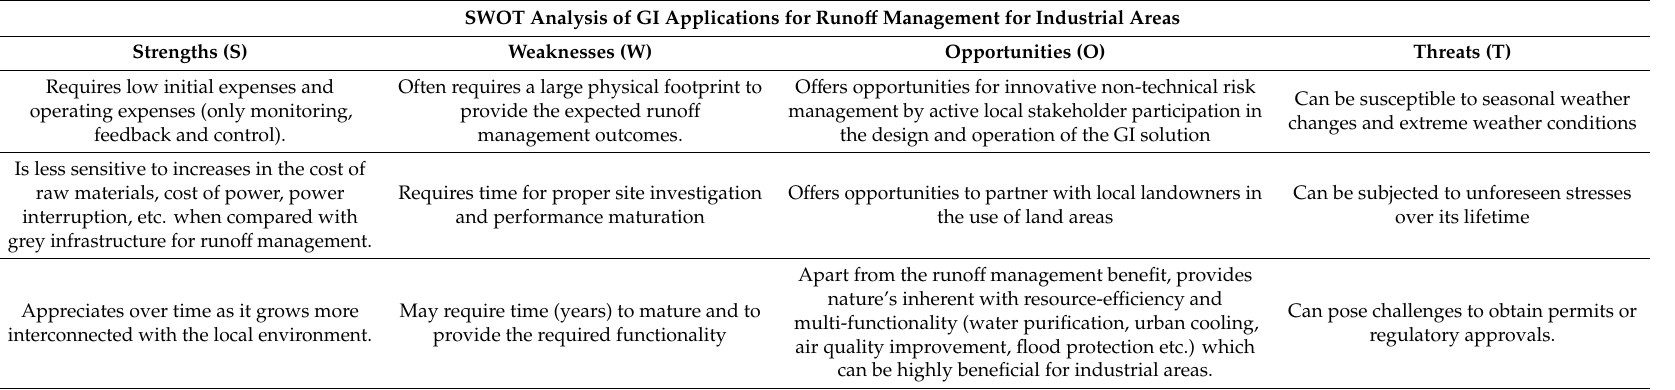
Table 5. SWOT analysis on applications of GI practices for industrial